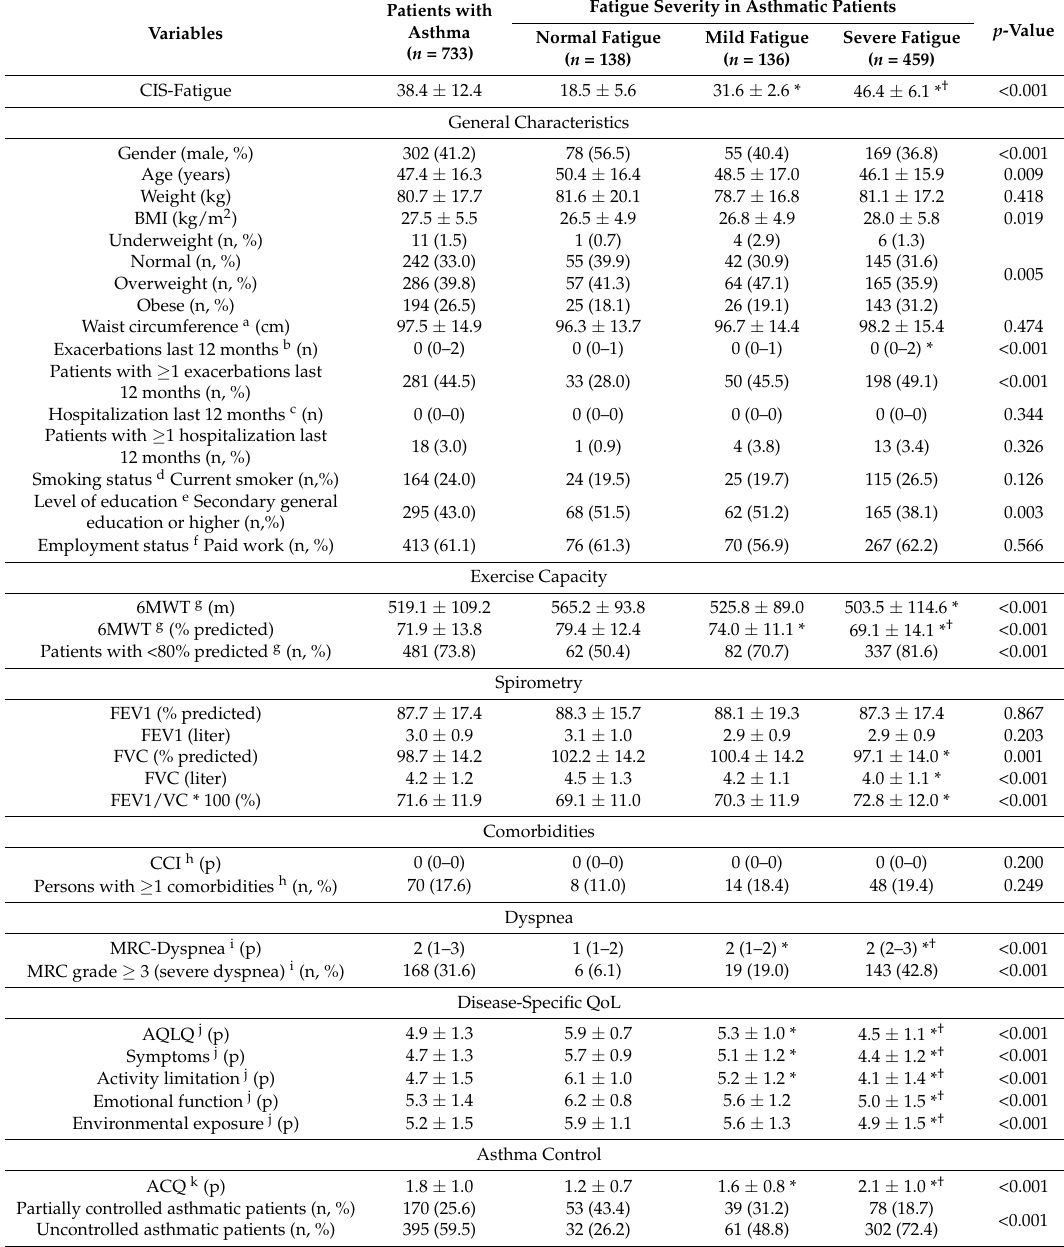
Table 1. General characteristics of patients with asthma ( n = 733) stratified for fatigue severity in normal, mild, or severe fatigue based on the Checklist Individual Strength-Fatigue (CIS-Fatigue)